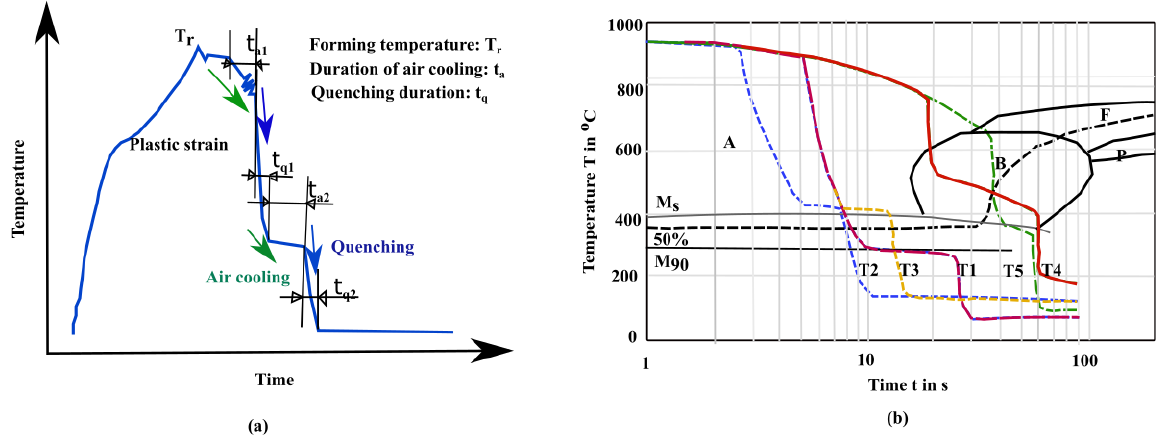
Figure 8: Heat process: (a) Intermittent Process Typical Cooling Cycle, (b) temps temperature of 22MnB5 Reprinted with permission from